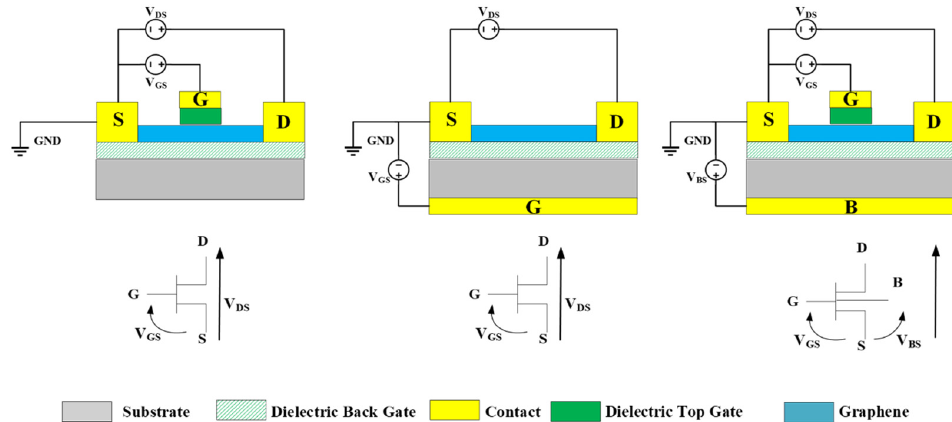
Figure 1. Most common topologies of graphene transistors. ( left ): Top-gated graphene transistor; ( center ): back-gated graphene transistor; ( right ): top-/back-gated graphene transistor.